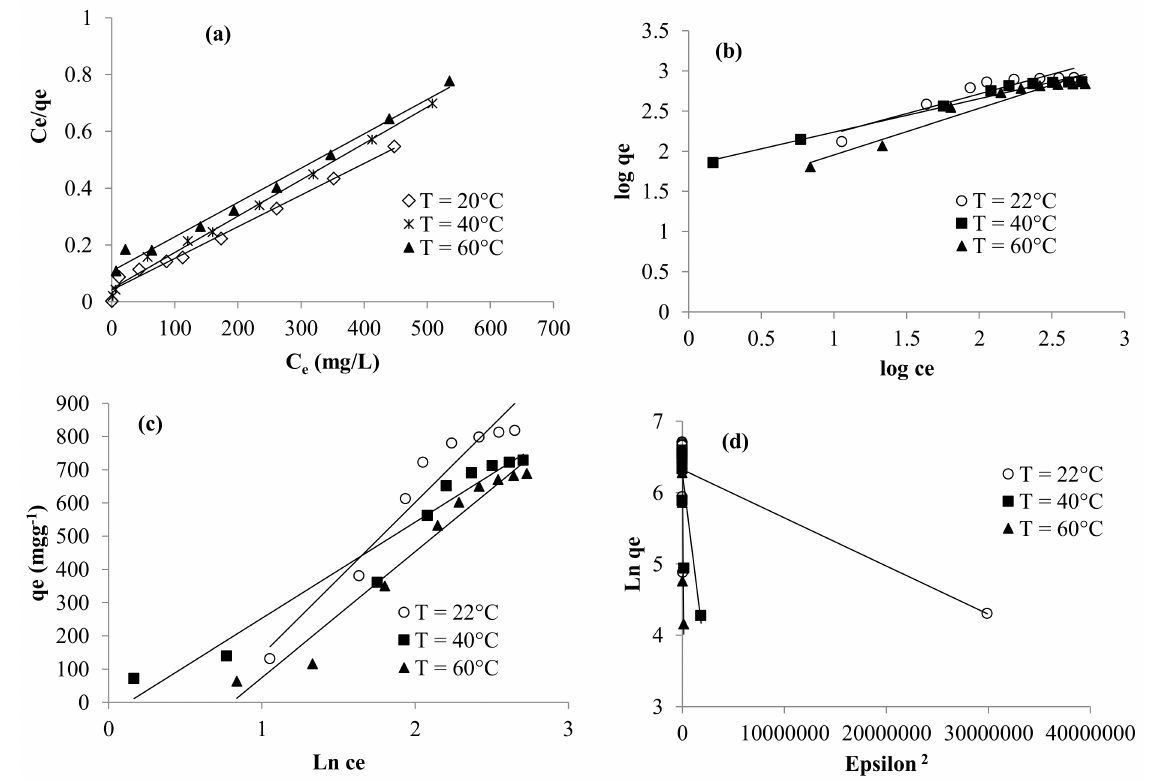
Figure 11. Langmuir ( a ), Freundlich ( b ), Temkin ( c ), and Dubinin ( d ) adsorption isotherm